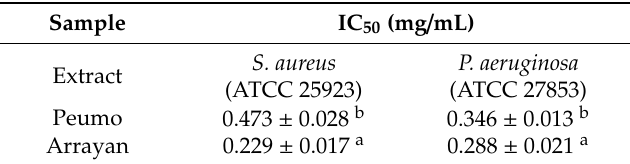
Table 3. Inhibition of biofilm formation.